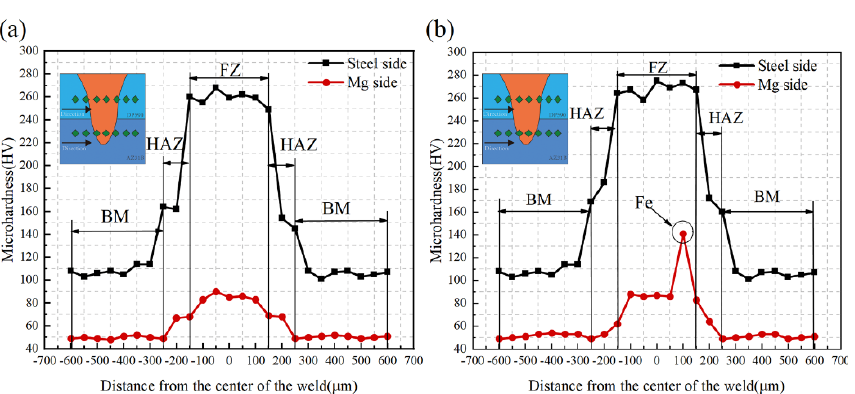
Figure 10. Microhardness of joints without Si and with 5%Si: ( a ) Cu − 0%Si and( b )Cu − 5%Si.